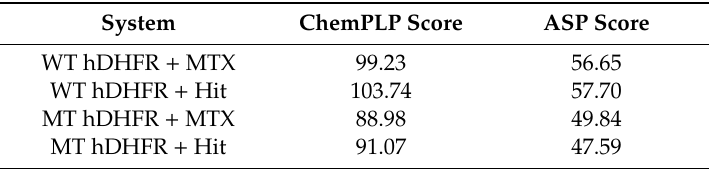
Table 3. Comparison of ChemPLP and ASP dock scores of MTX (reference inhibitor) and Hit compound in the active sites of WT and MT hDHFR.